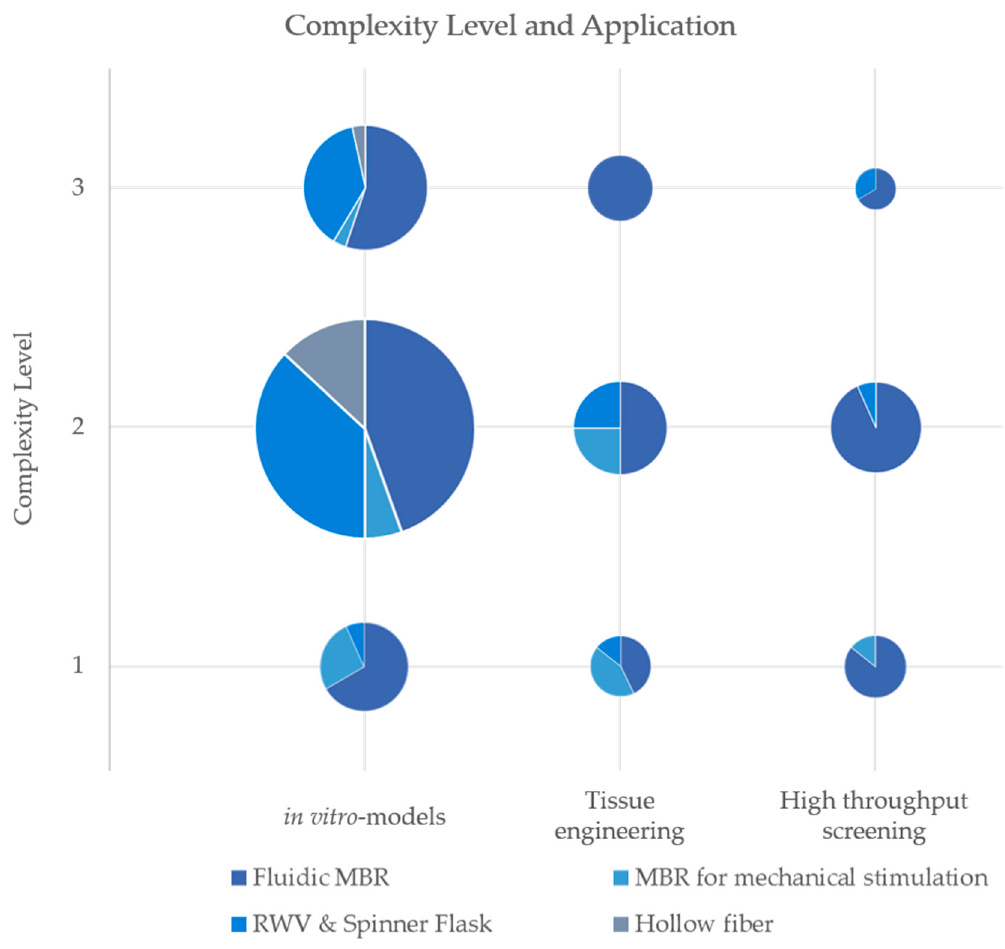
Figure 7. Application fields of the MBRs described in the analyzed literature with respect to the complexity levels. The dimensions of the pie charts reflect the number of publications in the respective application group and complexity level subgroup. Number of publications: 192.